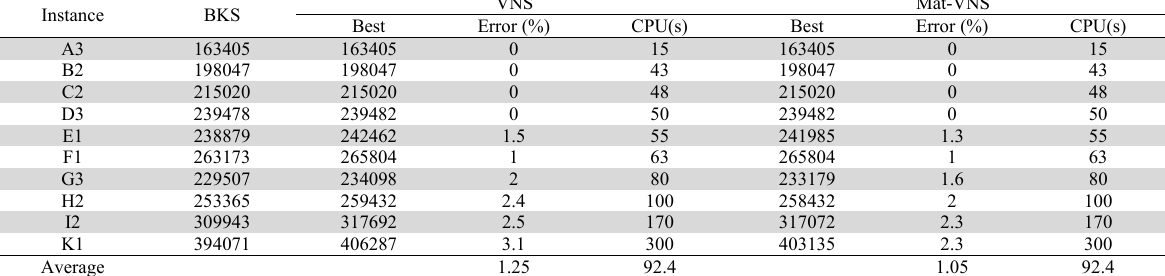
The obtained results from VNS and Mat-VNS algorithms for VRPB test problems